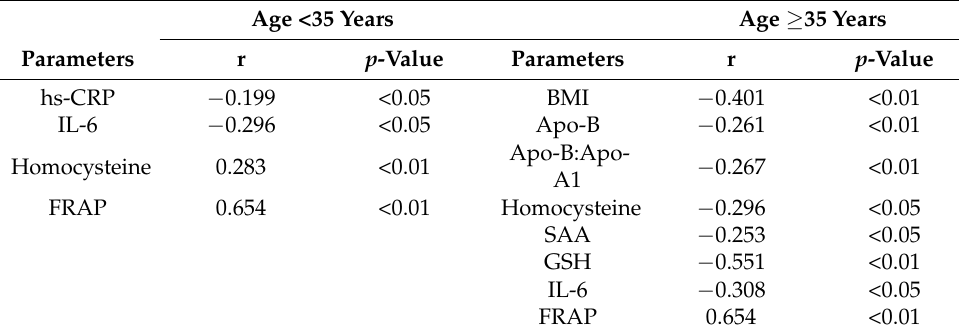
Table 5. Correlations with UCB concentrations in age